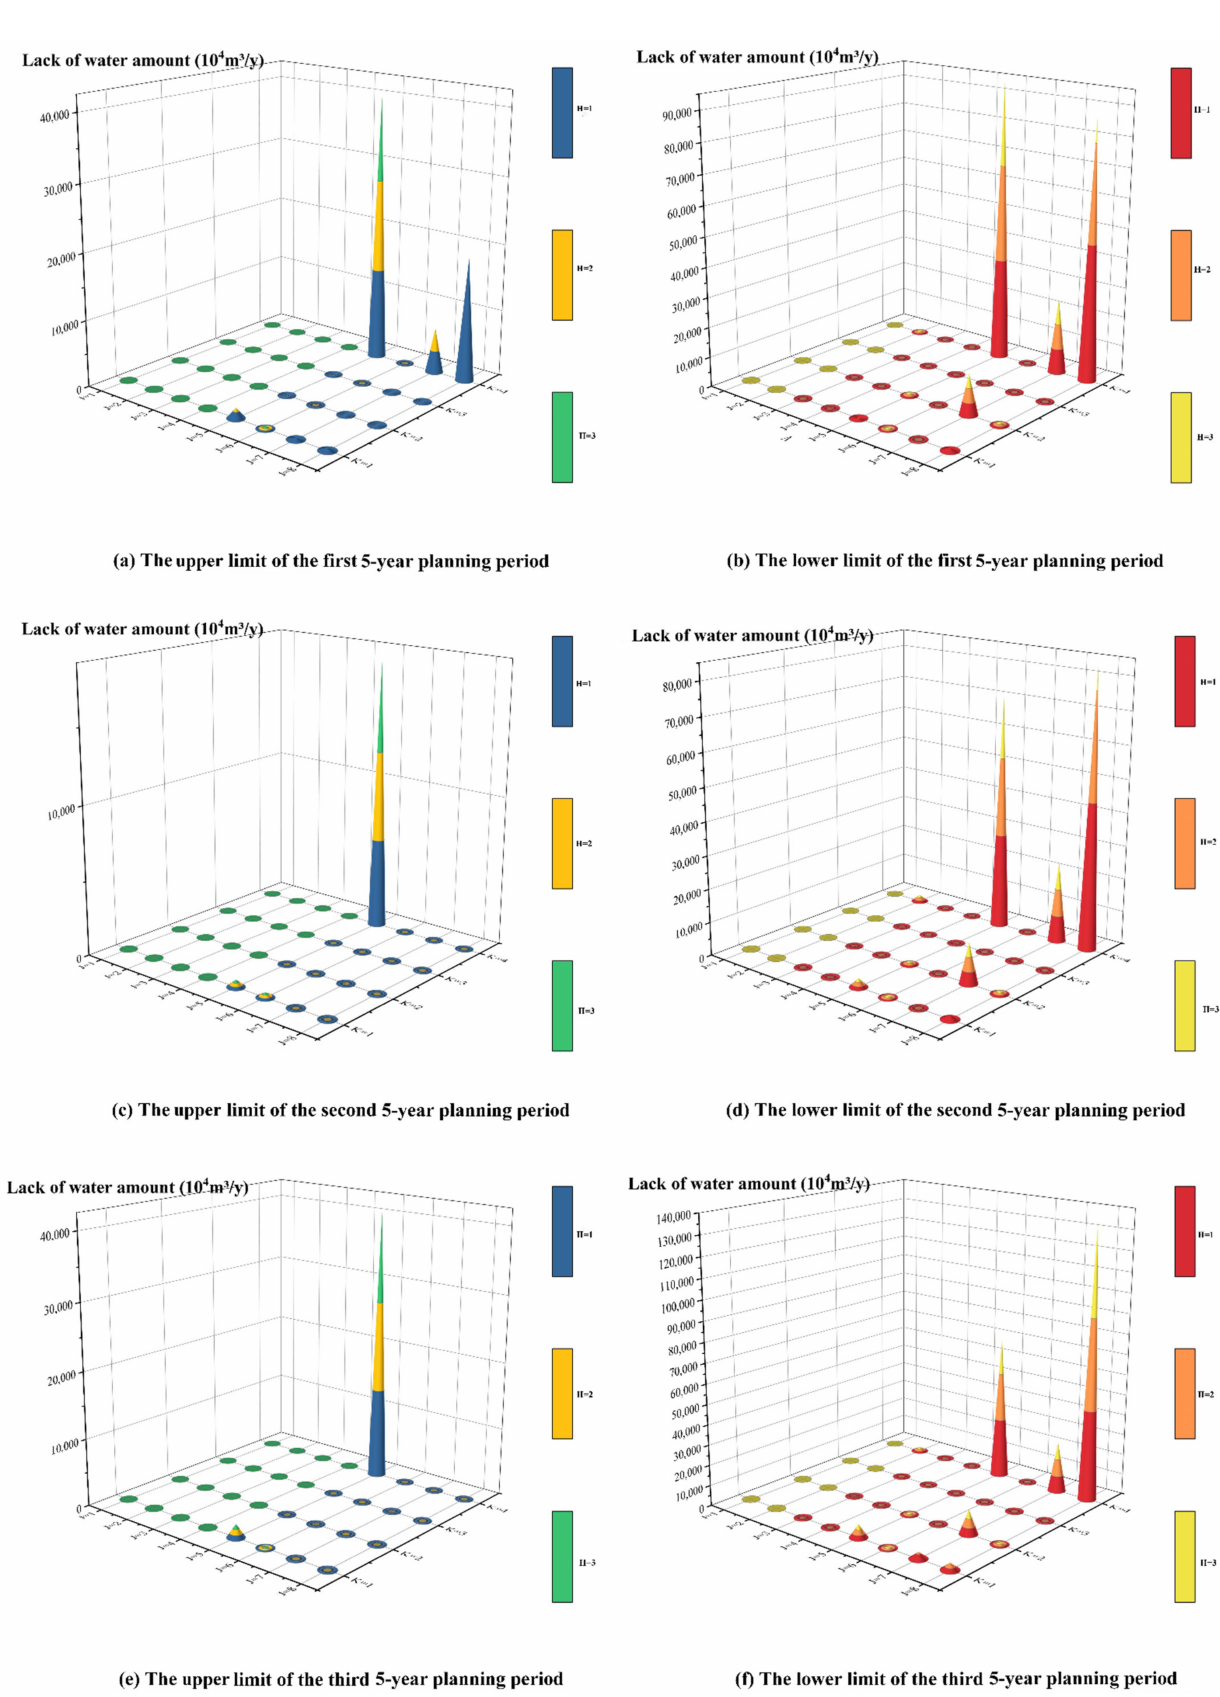
Figure 5. Water deficits by water-use sector (10 4 m 3 /year) under different scenarios for various planning periods in the Yinma River Basin. ( a ) The upper limit of the first 5-year planning period water deficits by water-use sector under